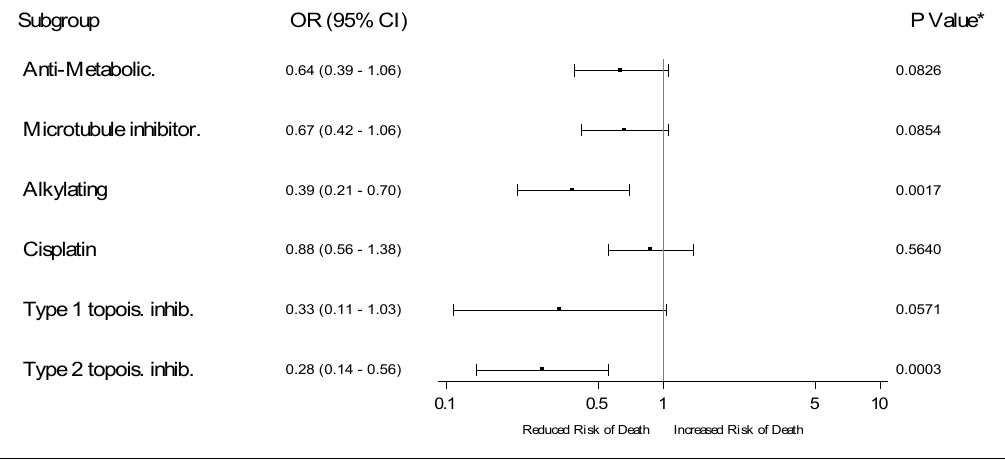
Figure 3. Summary of propensity score pair matching by drug classes. Each row represents a unique propensity score pair matching. The variable balances can be accessed by drug in Supplementary Tables. Abbreviations: Inhib: Inhibitor; Topois: Topoisomerase. * Wald conditional logistic regression p-value